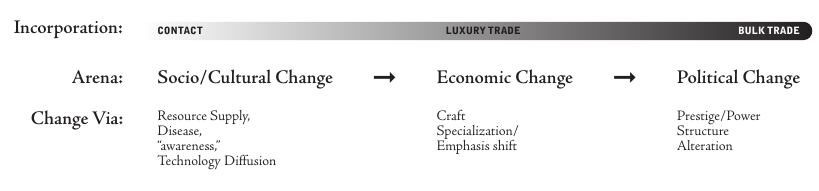
Figure 3 – A Preliminary Flowchart: Arenas of Change Leading to